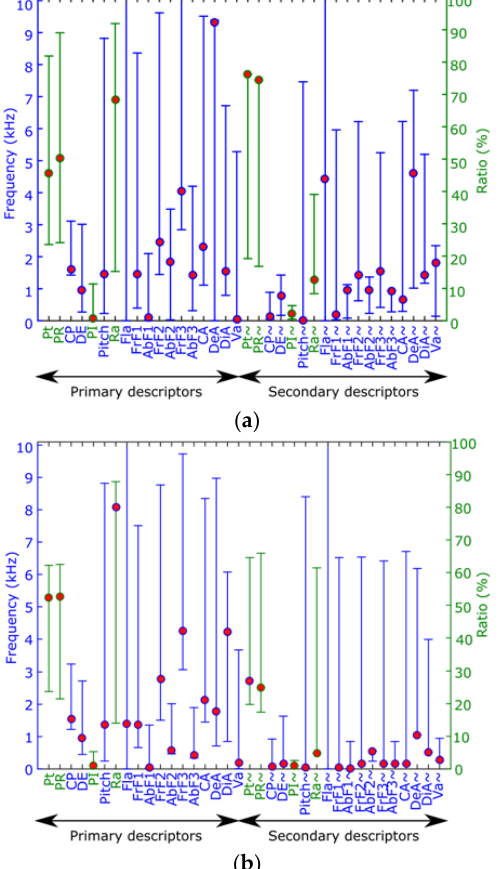
Figure 7. Examples of primary and secondary descriptors for two different frames. ( a ) Epidalea calamita (0501) t = 0.5; ( b ) Alytes obstetricans (1325) t = 0.8.